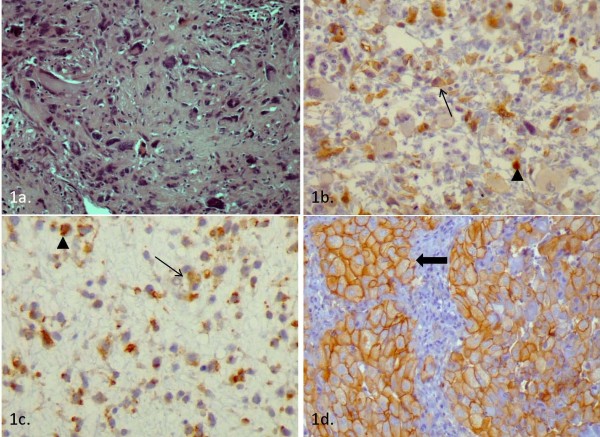
a) Retroperitoneal pleomorphic liposarcoma (H&E x400) b) Weak expression of beta-catenin in pleomorphic retroperitoneum liposarcoma (< 20% of neoplastic cells showed cytoplasmic immunoreactivity (long arrow) and < 5% nuclear immunoreactivity (short arrow) (DAB X400)). c) Weak expression of beta-catenin in extremity liposarcoma ((< 20% of neoplastic cells showed cytoplasmic immunoreactivity (long arrow) and < 5% nuclear immunoreactivity (short arrow) (DAB x400). d) Area with extensive membranous and cytoplasmic expression of beta-catenin in an extremity liposarcoma ((< 50% of neoplastic cells showed cytoplasmic and membranous immunoreactivity (long arrow) (DAB x400)).